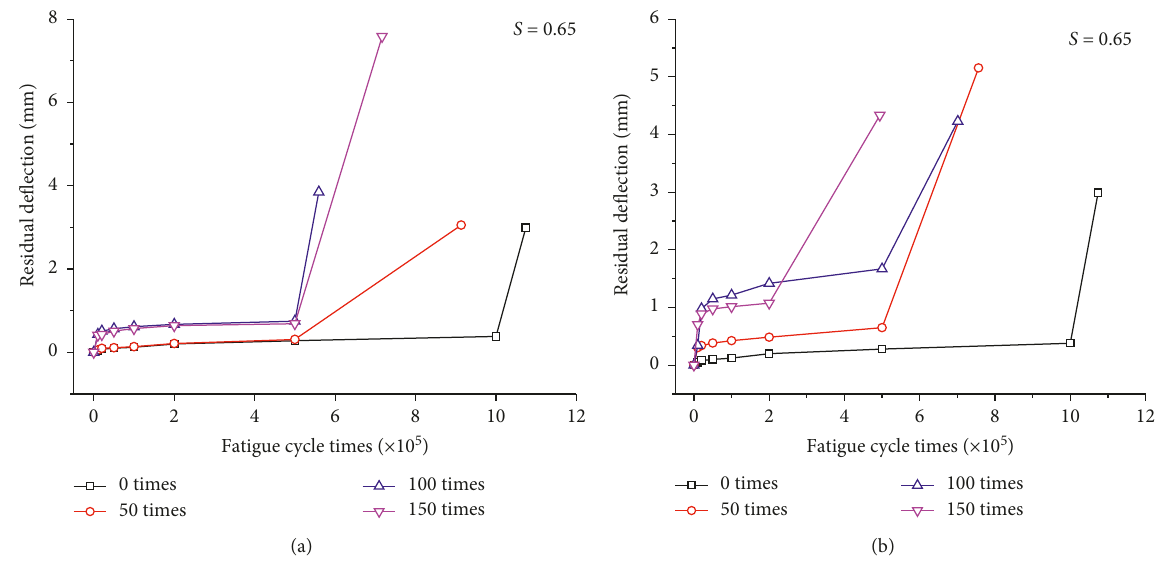
Figure 11: Residual deflection diagram. (a) Water-frozen specimen. (b) Salt-frozen